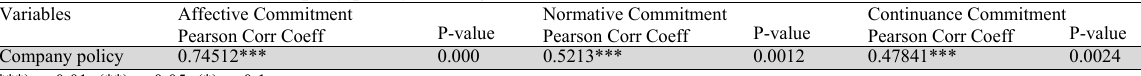
Pearson correlation between company policy and organizational commitment Variables